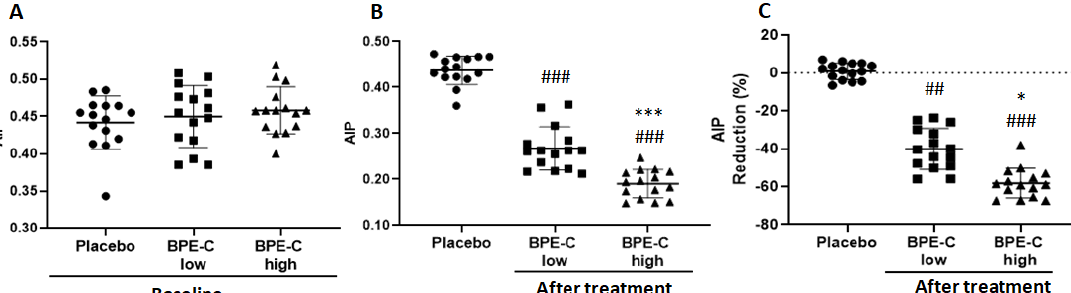
Figure 3. BPE-C reduces triglycerides and fasting serum glucose levels in MetS patients. A ) TG levels before (baseline) A) and B) after 90-days intervention on MetS patients assigned to three experimental groups (Placebo, BPE-C low and high). C) percent reduction calculated for B. D ) Baseline fasting serum glucose levels and E ) after 90 days as in B. F) percent reduction calculated for E. Statistical differences were analyzed by ANOVA (A, B, D and E) or Kruskal – Wallis (C and F) tests followed by Bonferroni’s or Dunn’s post-hoc tests, respectively. The analysis revealed significant differences in BPE-C treatment groups when compared to Placebo at ## p ≤ 0.01; ### p ≤ 0.001 or #### p ≤ 0.0001 and between BPE-C treatment groups at * p ≤ 0.05; ** p ≤ 0.01 or **** p ≤ 0.0001. Horizontal lines represent the mean ± SD.